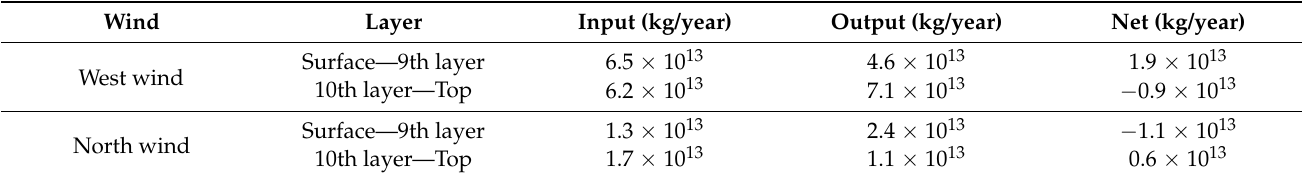
Table 2. The input and output of water vapor by the west wind and north wind over the HRB. Wind Layer Input (kg/year) Output (kg/year) Net (kg/year) West wind